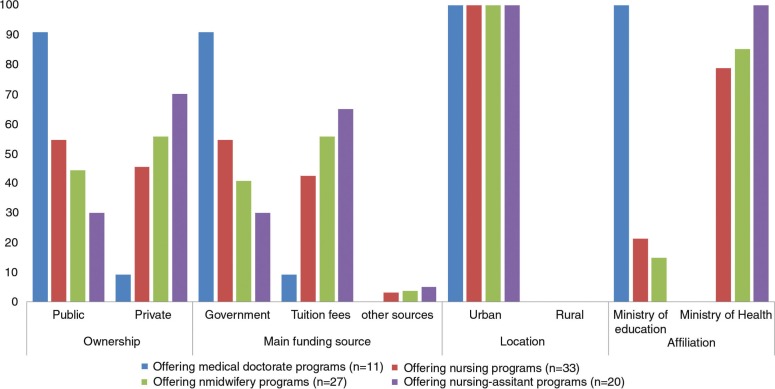
Characteristics of participating institutionsa (n=52).
aNote that there were institutions offering more than one training program.